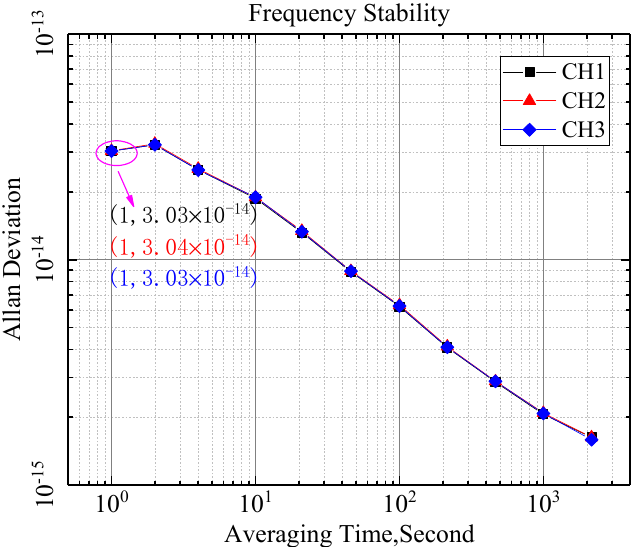
Figure 10. The frequency stability of three measurement channels without systematic error elimi- nation.